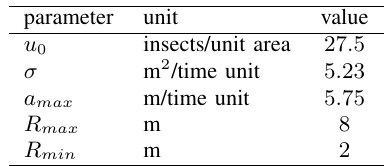
E LASTICITY OF THE PARAMETERS WITH RESPECT TO THE INCOMING STREAMS OF INSECTS . L ET ν DENOTE A PARAMETER , AND z ( ν ) THE INCOMING STREAM OF INSECTS WITH RESPECT TO ν , THEN , THE ELASTICITY INDEX OF PARAMETER ν IS